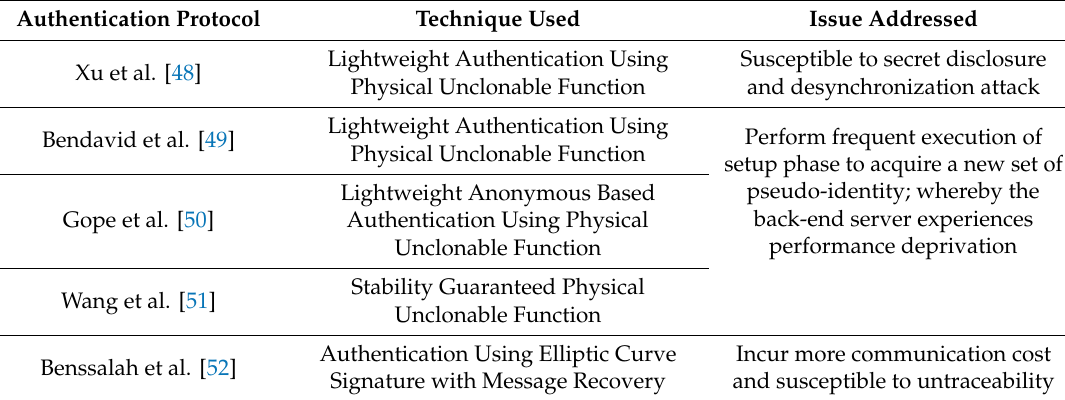
Table 1. Challenging issues of existing RFID-based authentication